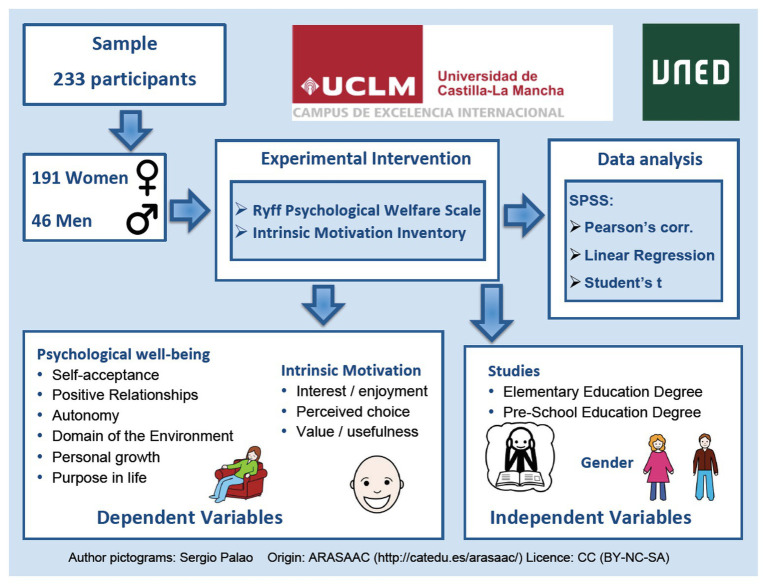
Research outline.